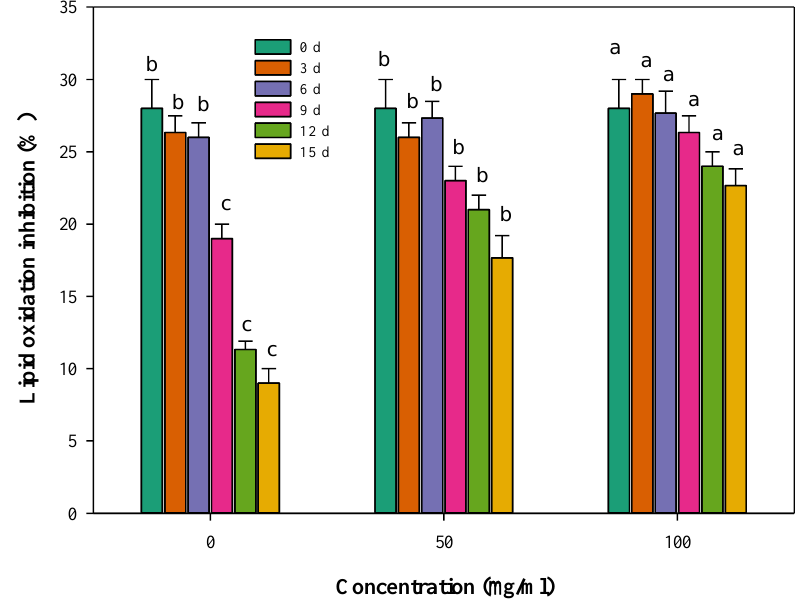
Figure 4. Changes in lipid oxidation inhibition (%) of minced beef combined with catfish glycoprotein (CFG) at different levels (0, 50 and 100 µg g −1 ) during 15 days storage at 4 °C. Every value is the average of three replicates ± SD. Different letters for the same time storage (same column color) refer to significant differences ( p < 0.05).